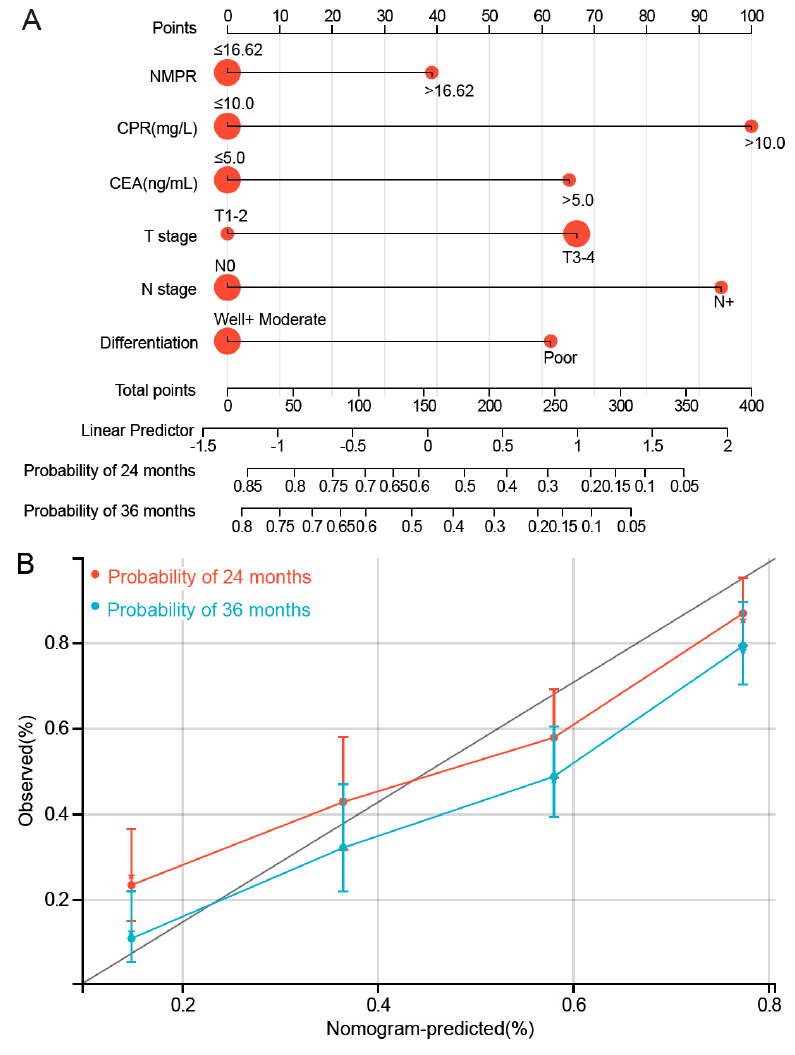
Figure 4. The nomogram ( A ) and calibration plots ( B ) for OS prediction in the training cohort. OS, overall survival; NMPR, neutrophil–mean-platelet-volume–platelet ratio; CRP, C-reaction protein; CEA, carcinoembryonic antigen. Table 3. Univariate and multivariate Cox regression analyses for overall survival in the external validation cohort (SY